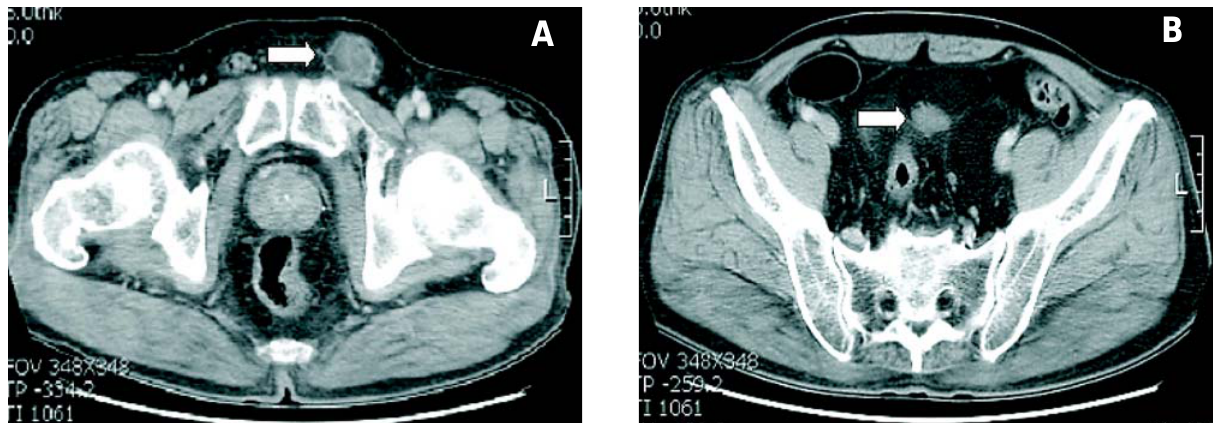
Figure 1 – Contrast-enhanced computed tomography of the pelvis. A) Partially fat containing soft tissue mass (arrow) at the left inguinal area. B ) Homogenous enhanced soft tissue mass (arrow) adjacent to sigmoid mesocolon.